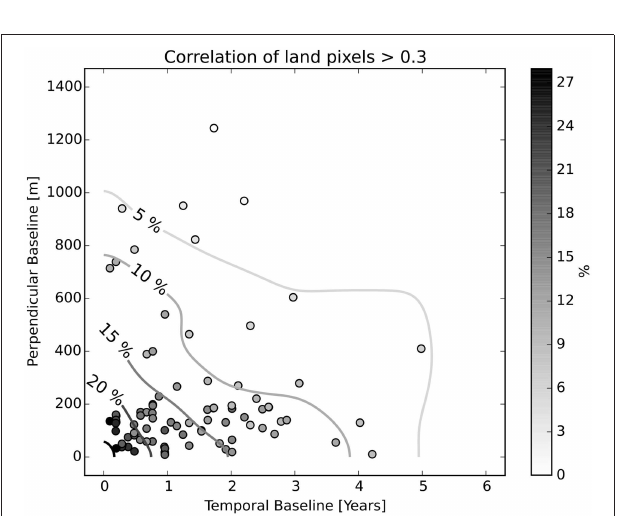
FIGURE 7 | Contours of percentage of coherent pixels ( > 0.3) on Pagan for C-band Envisat track 124 interferograms (beam 2/incidence = 23 ◦ ) as a function of perpendicular and temporal